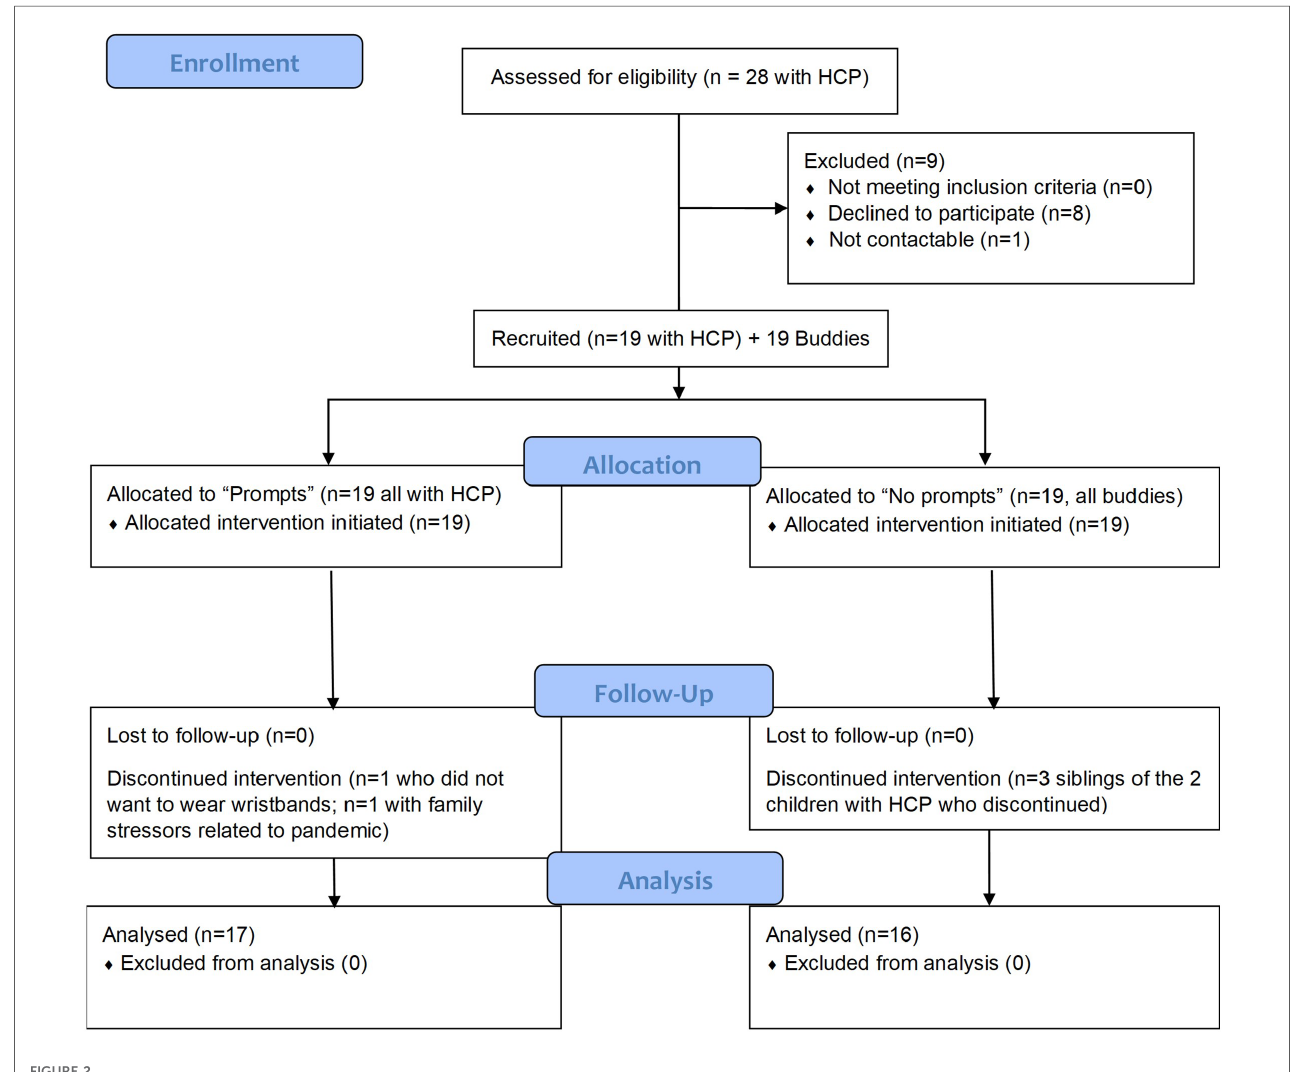
FIGURE 2 Participant fl ow